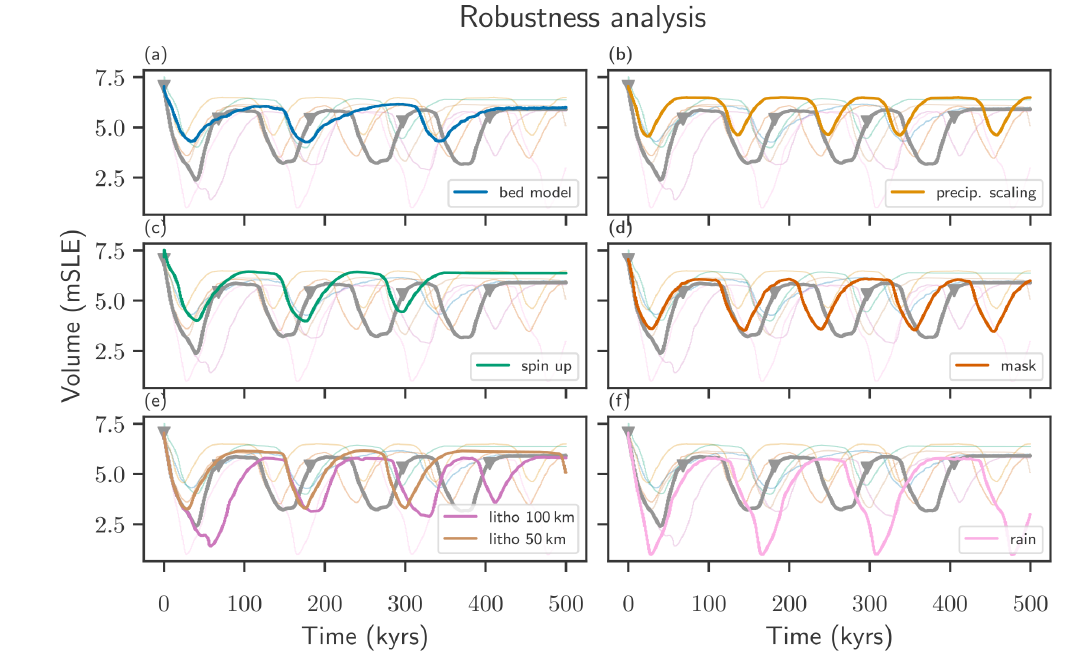
Figure 8. Robustness analysis for the simulation run with parameters (cid:48) = 6Kkm − 1 , (cid:49)T = 2K and η = 1 × 10 21 Pas. The gray curve corresponds to the reference run, also shown in Figs. 2 and 3 and is shown in each panel for reference. The colored faint lines provide context. Each change in modeling choice is highlighted in its own panel. (a) Run with an instantaneous pointwise isostasy model. (b) Run which includes a 7.3% precipitation increase per degree Celsius of global mean temperature increase. (c) Run which starts from a glacial spinup. (d) Run which omits the flux correction at the ice-free margin. (e) Runs with two different lithosphere thicknesses, 100 and 50km. (f) Run which uses a different interpolation between rain and